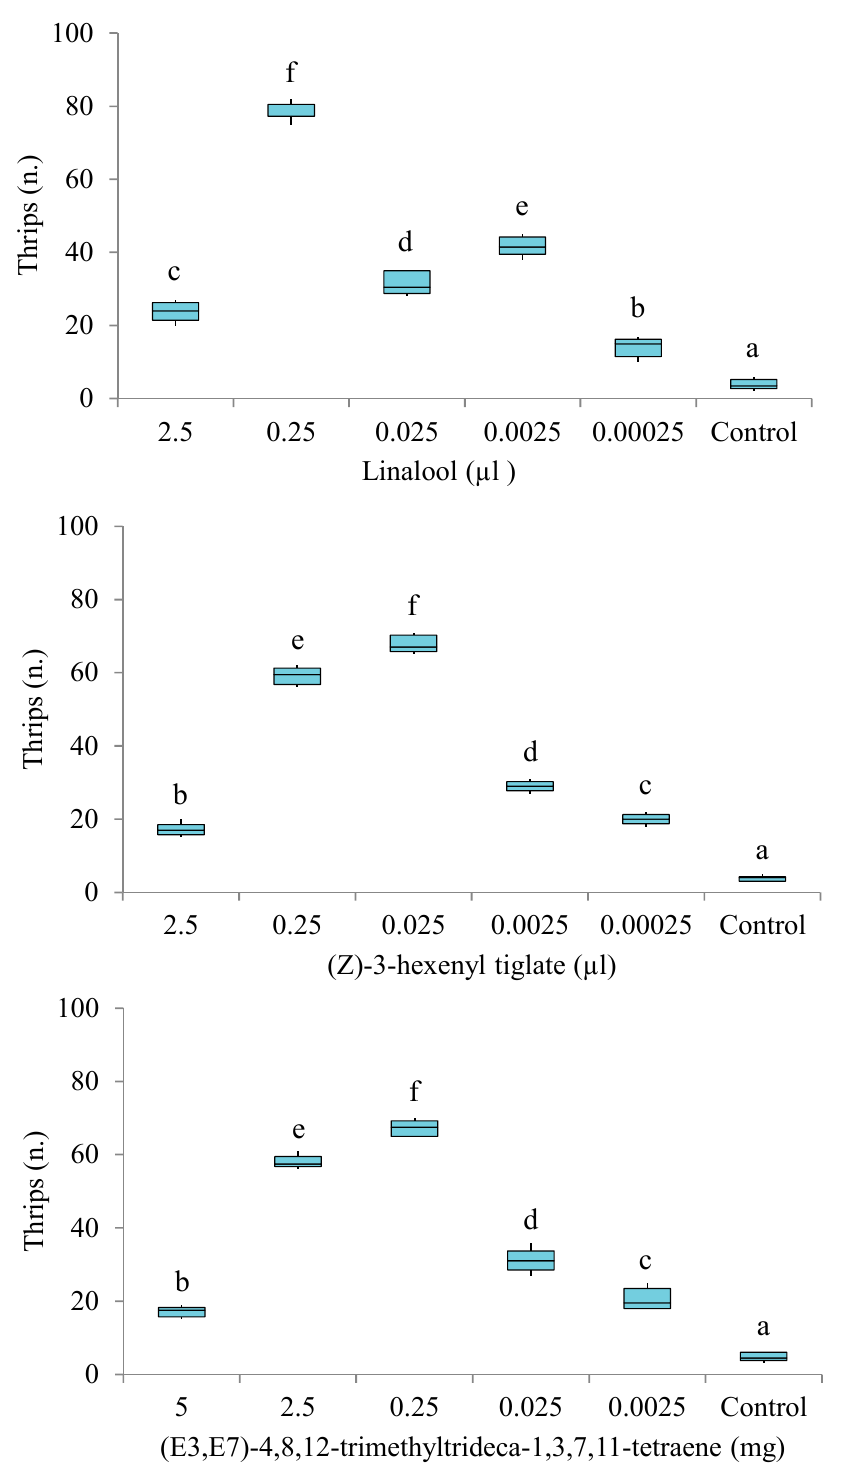
Figure 2. Olfactory responses of T. hawaiiensis to different doses of linalool, (Z)-3-hexenyl tiglate and (E3,E7)-4,8,12-trimethyltrideca-1,3,7,11-tetraene in a six-arm olfactometer. Control was mineral oil. Each box plot represents the median and its range of dispersion (lower and upper quartiles and outliers). Above each box plot, different letters indicate significant differences (Wilcoxon test, p < 0.05).